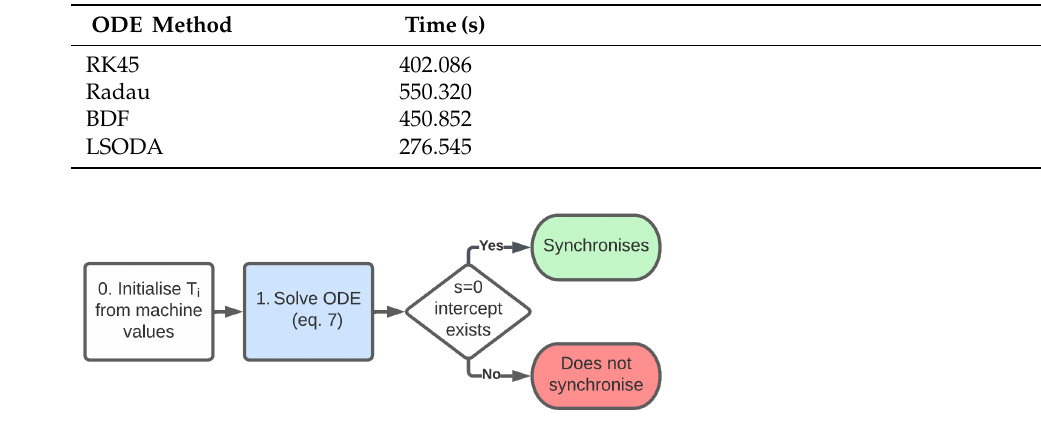
Figure 17. Adapted flowchart implementing the eneryg method (Chama et al.).